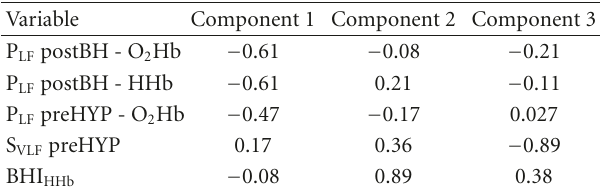
Table 2: PCA components . Weights of the three principal compo- nents of the PCA analysis in function of the five original